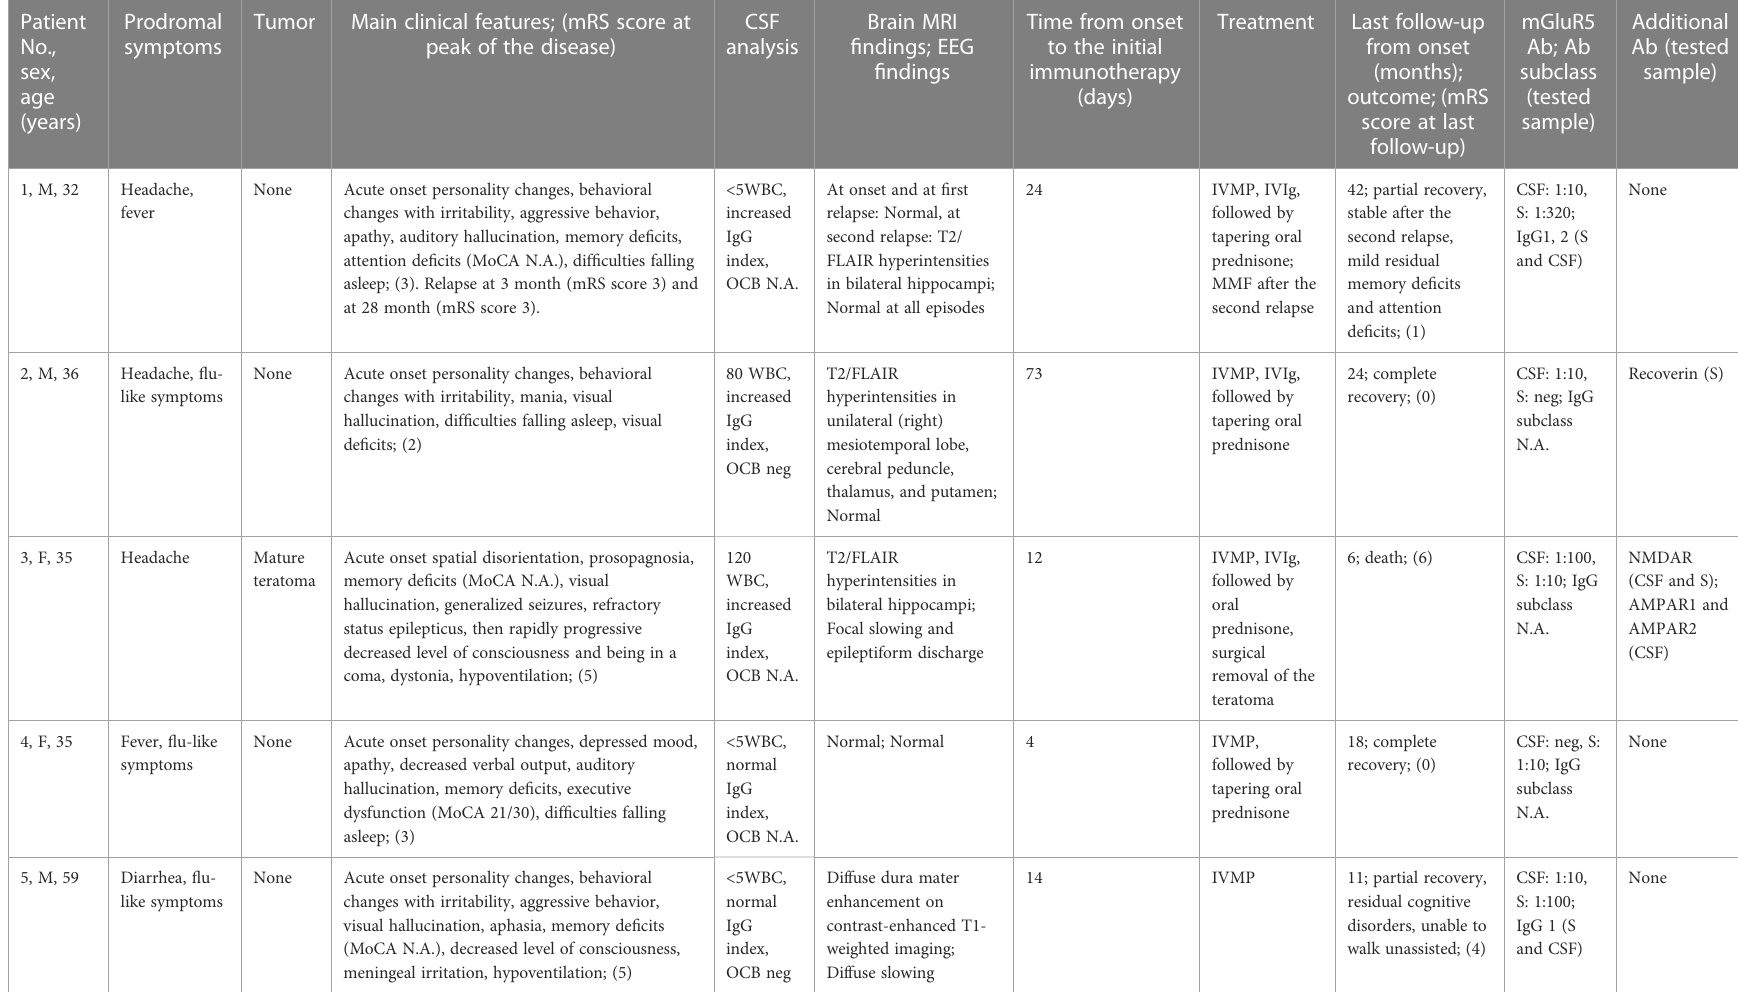
TABLE 1 Clinical information, antibody results, and clinical outcomes of fi ve autoimmune encephalitis patients with mGluR5